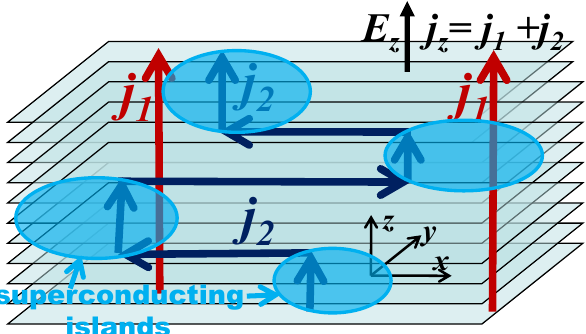
Figure 2. Illustration of two current channels, corresponding to two terms in Equation (1) for interlayer conductivity σ zz in a strongly anisotropic metal containing isolated superconducting